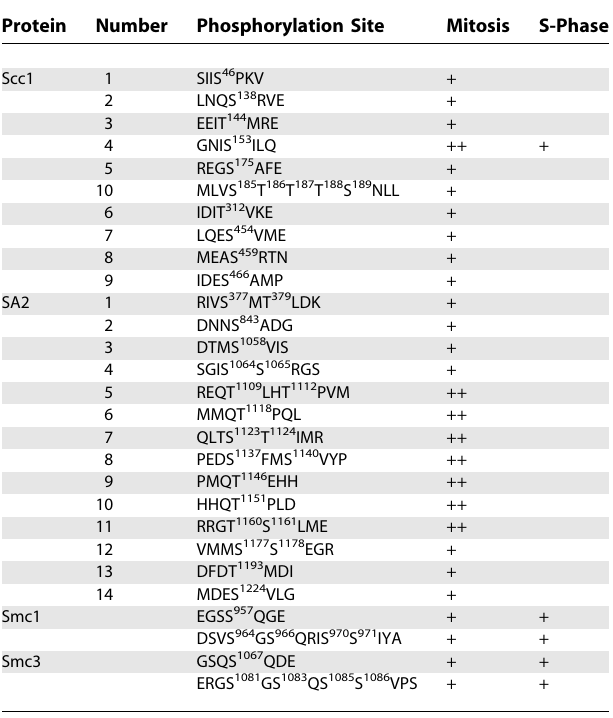
Table 1. Phosphorylation Sites Identified in Cohesin Subunits